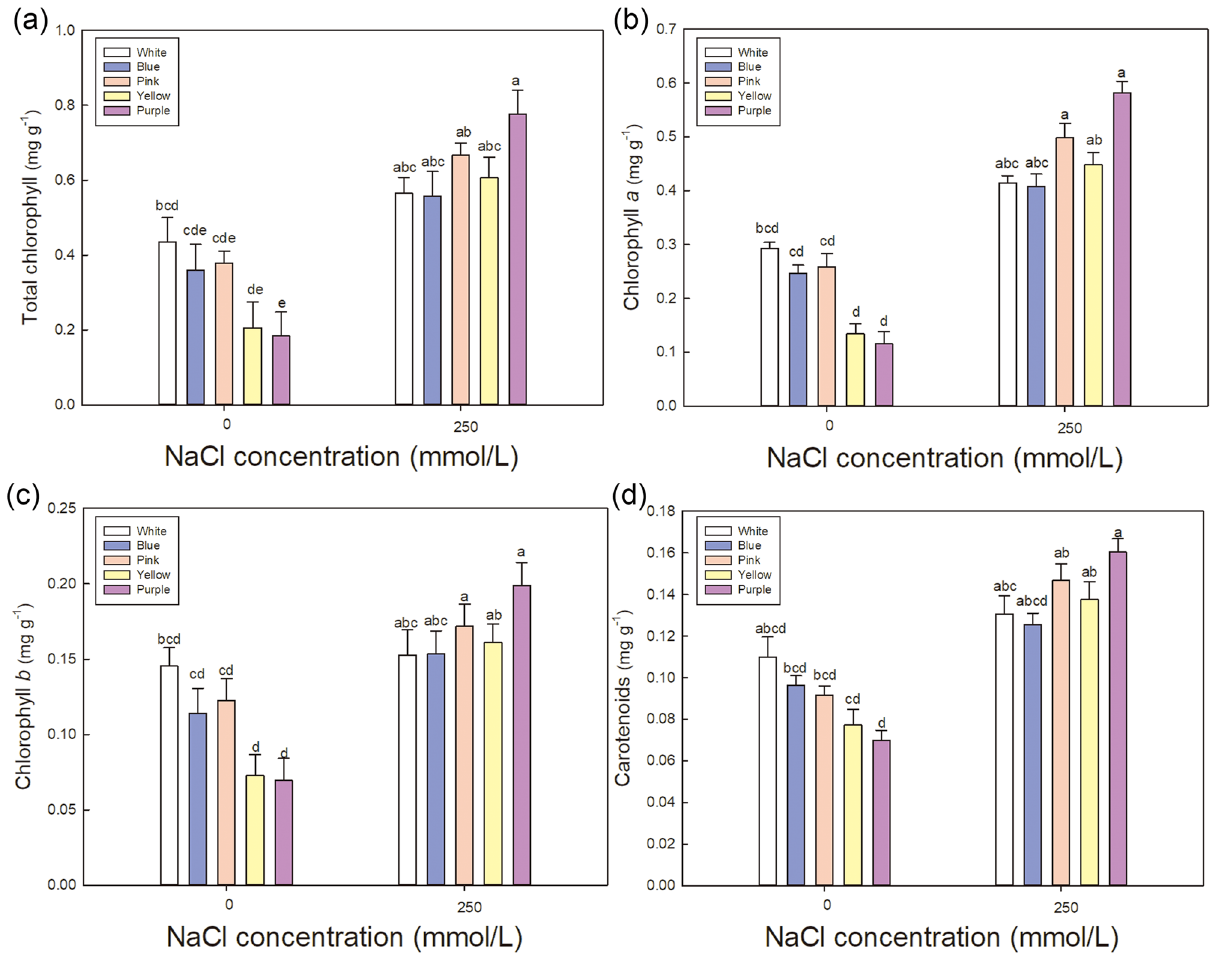
Figure 7. Effect of NaCl treatment on chlorophyll contents in the leaves of five varieties of Limonium sinuatum . ( a – d ) Total chlorophyll, chlorophyll a , chlorophyll b , and carotenoid contents under control and NaCl treatment. The data are means ± SD of five replicates. Different letters indicate significant differences between two groups at P = 0.05 using Duncan’s test with potential, photosynthetic rate, and salt gland density under 250 mmol/L NaCl (salt-tolerance threshold) treat- ment explained why Pink has the greatest salt tolerance. Moreover, analysis of plants grown in the field (Fig. 10) confirmed the superior salt resistance of Pink . Pink is recommended as the optimal varieties for extensive planting and greening in saline soil, followed by Yellow . Plant biomass is an important indicator of salt tolerance 43 : the greater the increase in biomass under salt stress, the higher the salt tolerance. As shown in Fig. 4, Pink showed the minimal reduction under 250 mmol/L NaCl treatment, and photosynthetic efficiency of Pink was also the highest among five varieties (Fig. 8), indicating that Pink suffered the least damage under saline condition . The three basic components of salt stress are usually considered as ionic toxicity, osmotic stress and oxidative stress 49 . How Pink cope with high ionic toxicity? On the one hand, under salt stress, Na + content increases, which affects the absorption of K + and Ca 2+ . K + plays an important role in the osmotic regulation of cells 50 . Ca 2+ regulates the ionic balance and reduces the absorption of Na +51 . In salt-tolerant plants, K + efflux is significantly inhibited under salt stress to maintain high intracellular K + /Na + levels, thereby reducing the damage from salt stress 52 . After salt treatment, the Pink variety had the relatively low Na + and Cl − contents among the five varie- ties, whereas K + and Ca 2+ showed the opposite trend. Therefore, Pink regulates ionic balance under salt stress, maintaining high K + /Na + levels, thus showing strong salt tolerance. On the other hand, salt gland is the typical and specific epidermal structure of recetohalophytes 53 , which can excrete the excessive Na + out of the plants to avoid damage 54 . The most salt gland was induced in Pink under salt treatment (Fig. 9), so it is speculated that Na + can be effectively transferred out of the cell to further avoid ionic toxicity. NaCl can induce the physiological drought due to the osmotic stress. Compatible media was always generated to deal with the osmotic stress, such as proline and soluble sugars. Proline is an important compatible solute in plant cells that protects enzymes from inactivation by NaCl and reduces the osmotic potential in the cells 55 , thereby helping plants resist external osmotic stress and tolerate adverse environments 29 . Sugar content under stress condition is intricately associated with carbohydrate content of plant 25 . Though not always the highest